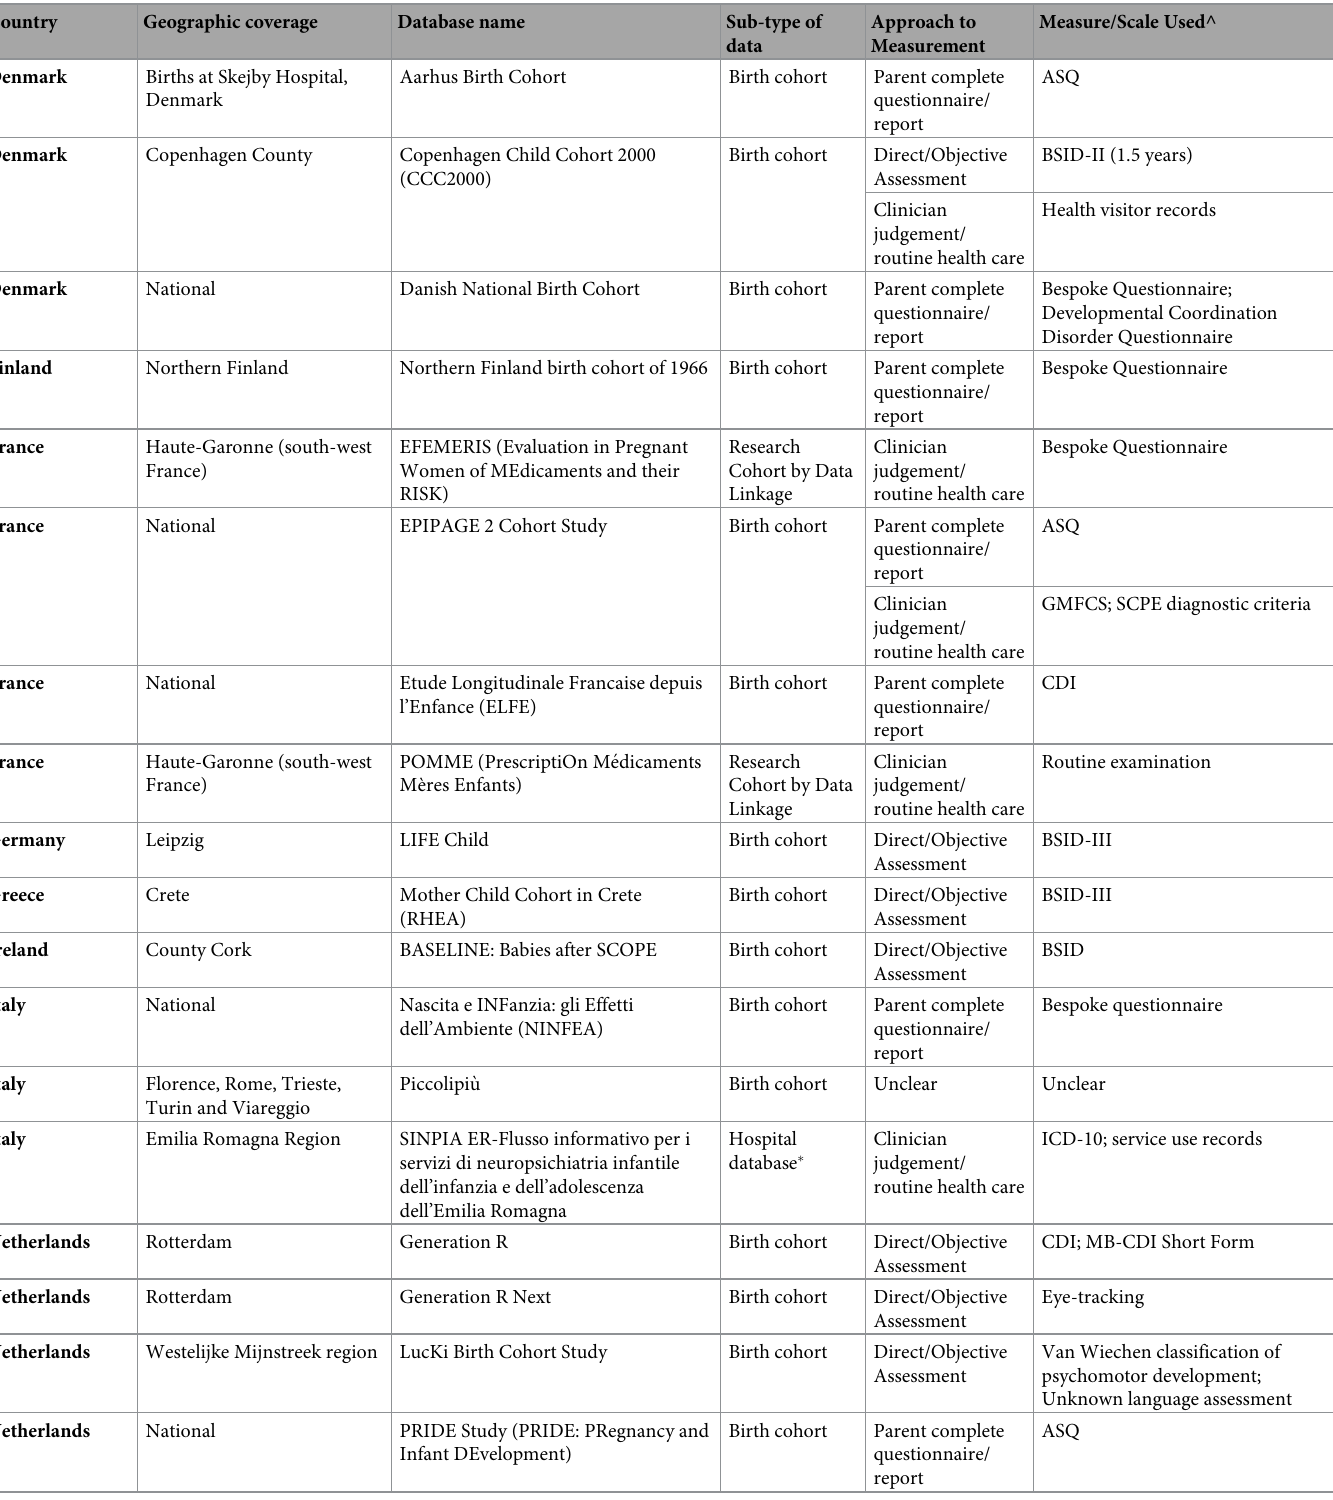
Table 1. Data sources which record infant